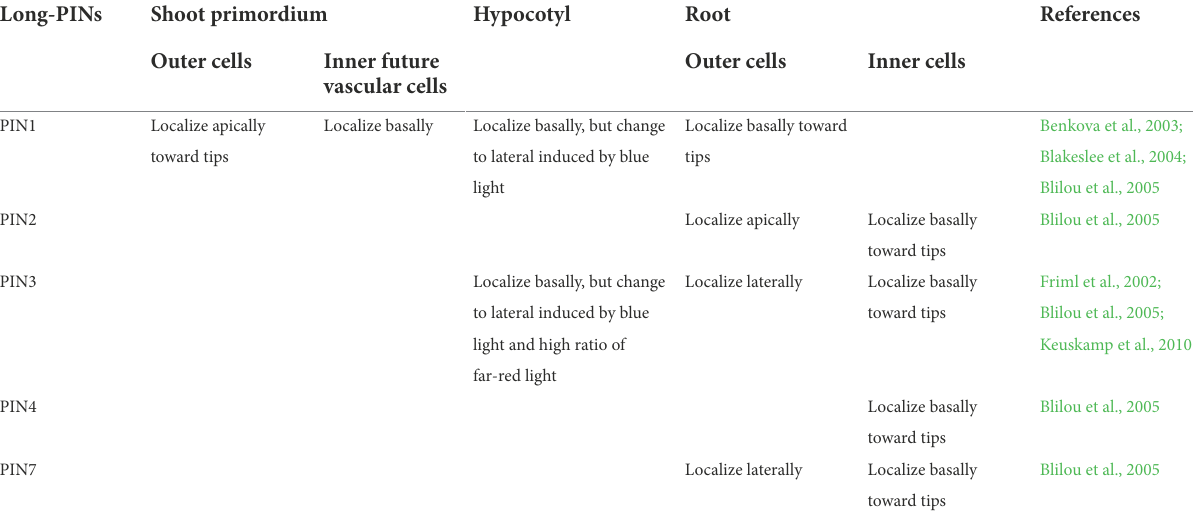
TABLE 2 Polar localization of long PINs in different